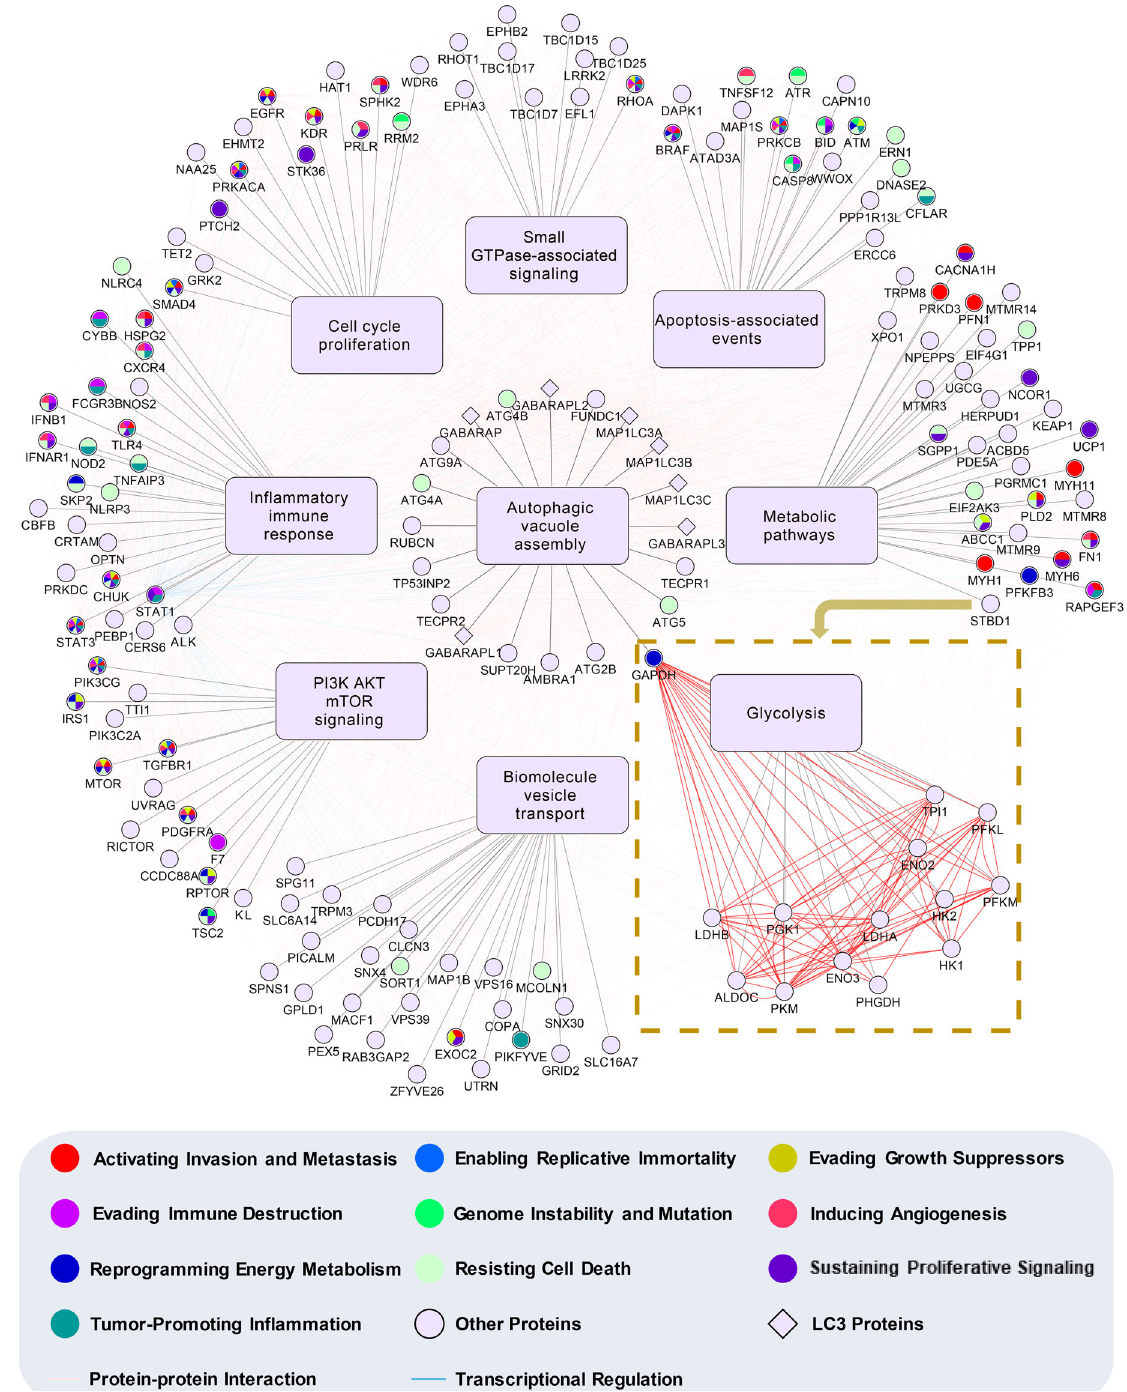
Fig. 7 A LIRCP-regulating network that connects autophagy and carcinogenesis. The 148 LAM-containing ATG proteins and autophagy regulators were classi fi ed into nine groups based on their major biological function. Both PPIs and transcriptional regulations were incorporated for these proteins if available. The downstream pathway, glycolysis, and corresponding proteins in the pathway regulated by STBD1 were also